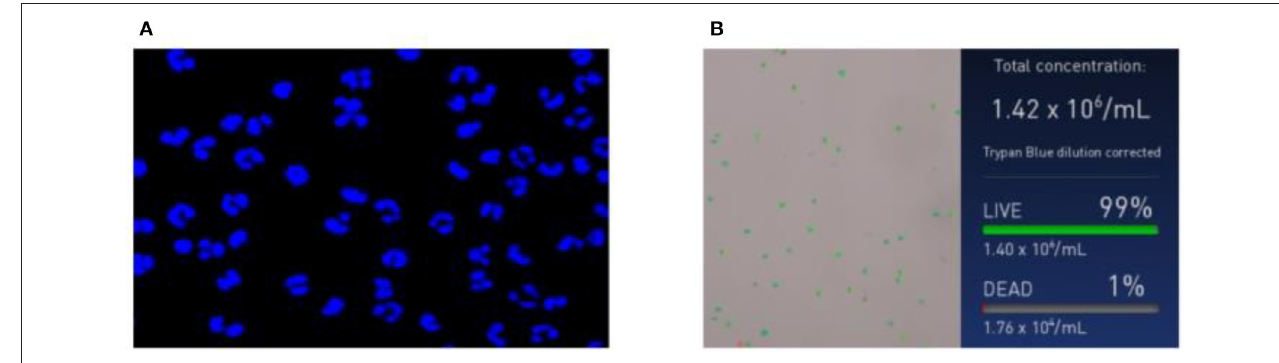
FIGURE 1 | Neutrophil identification results. (A) Morphological images of neutrophils and (B) concentration and survival rate images of